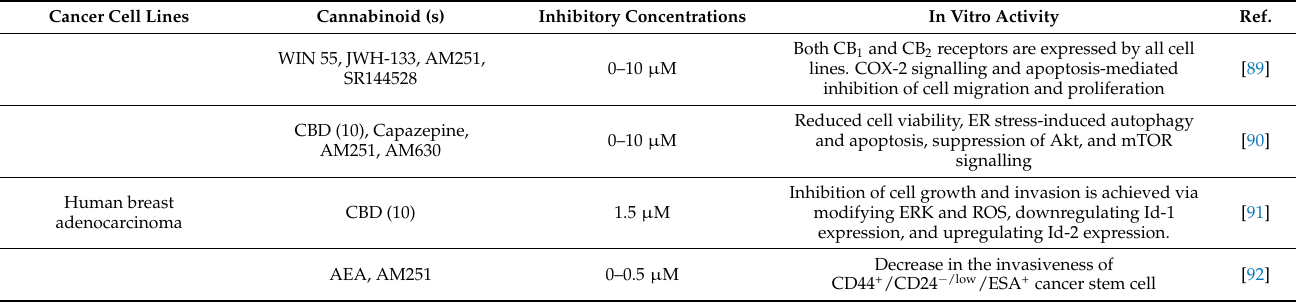
Table 2. Current pre-clinical in vitro research on different cannabinoids in cancer cell